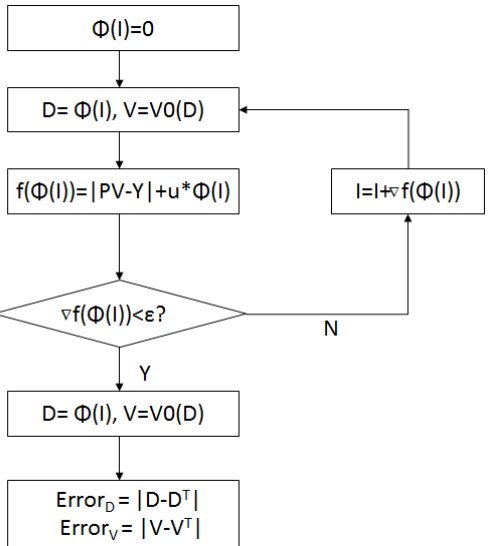
Figure 1. The flowchart of B-spline-based reconstruction method. To evaluate the similarity between the reconstructed target image ( V R ) and the ground-truth target image ( V T ), three intensity-based statistical metrics, normalized cross correlation, mutual information and mean absolute percentage error, were employed. Normalized cross correlation (NCC) was defined as